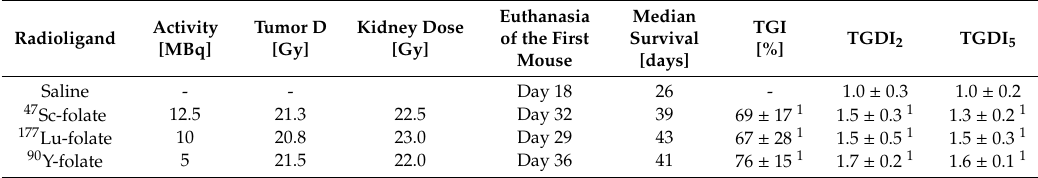
Table 2. Analysis of the therapy